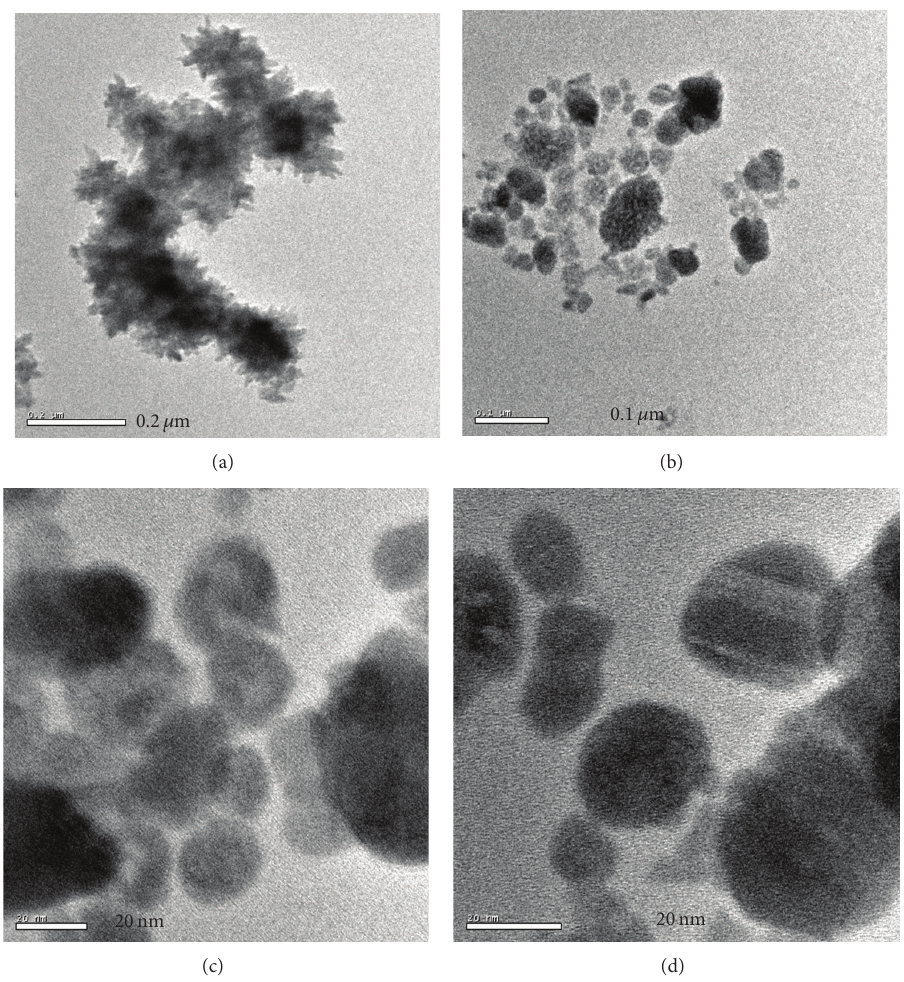
versus reaction 𝜆𝜆 max